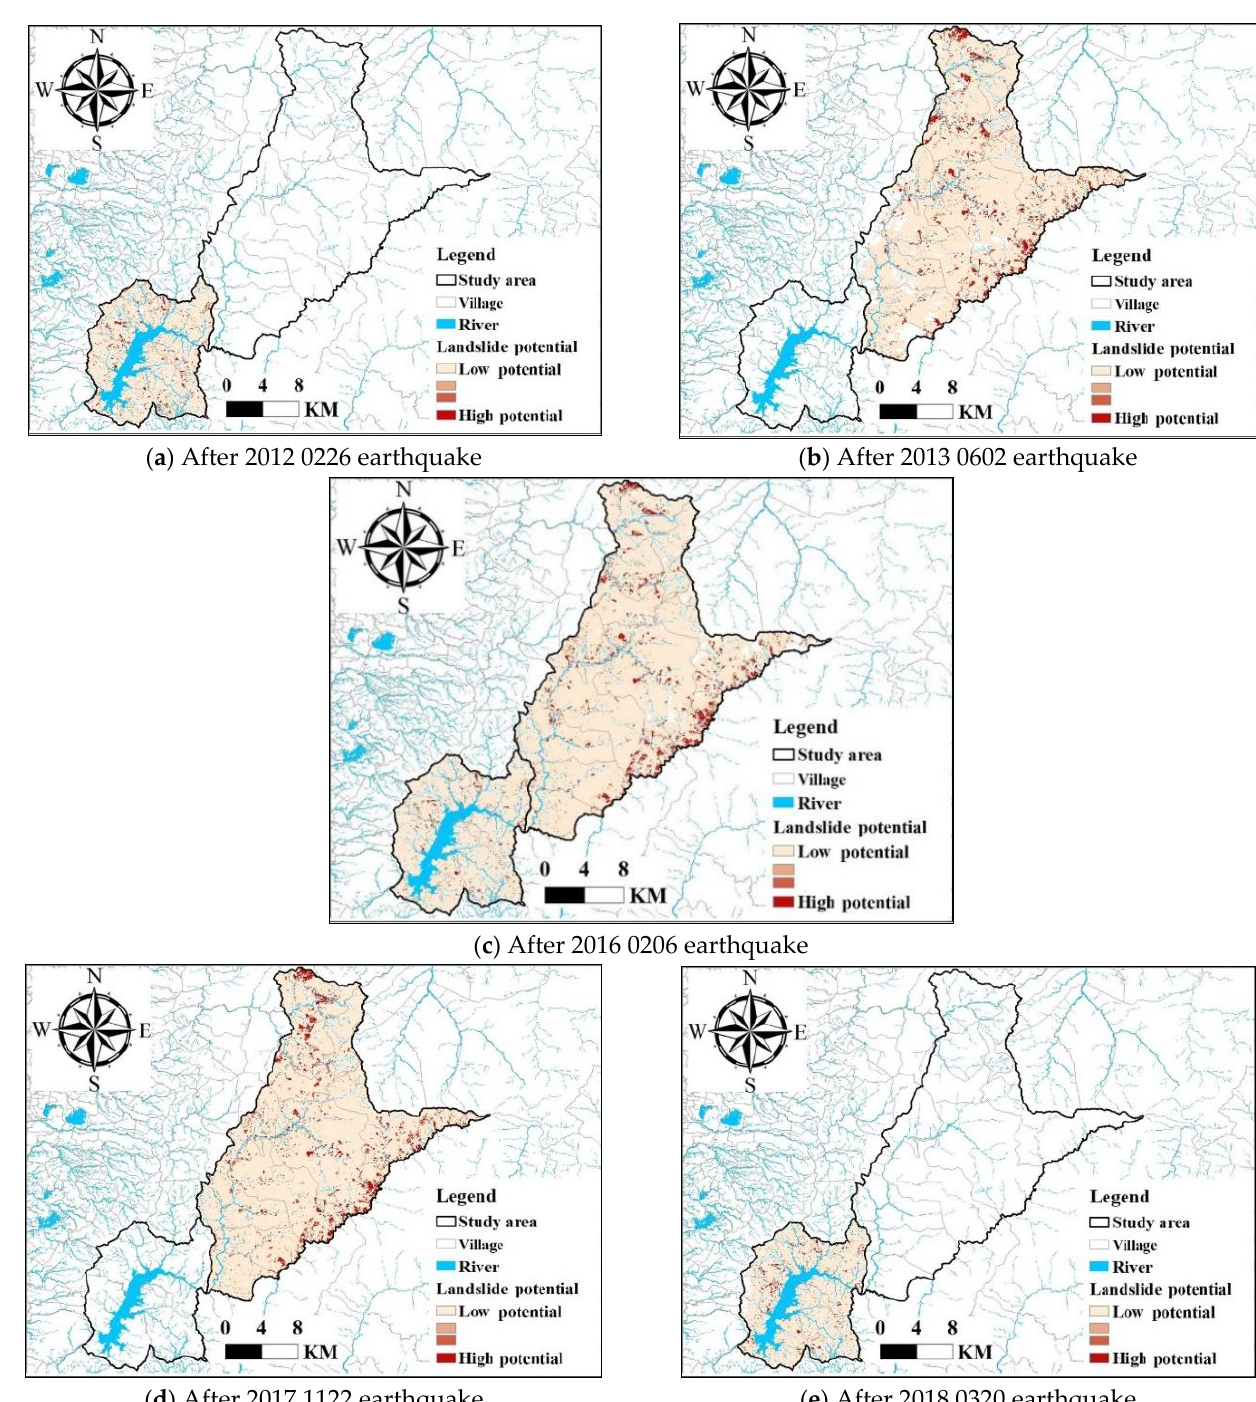
Figure 7. Single earthquake-induced landslide potential.